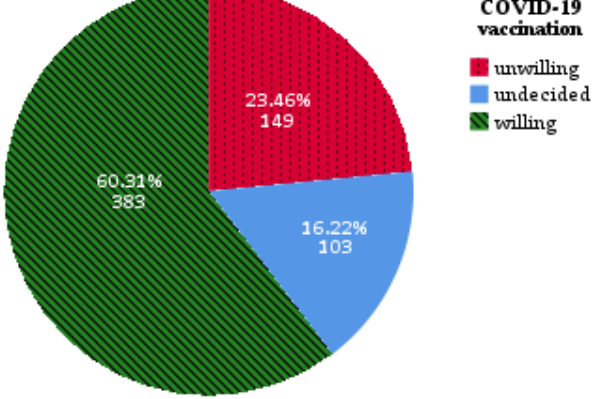
Figure 1. Patients’ willingness to get vaccinated against COVID-19.